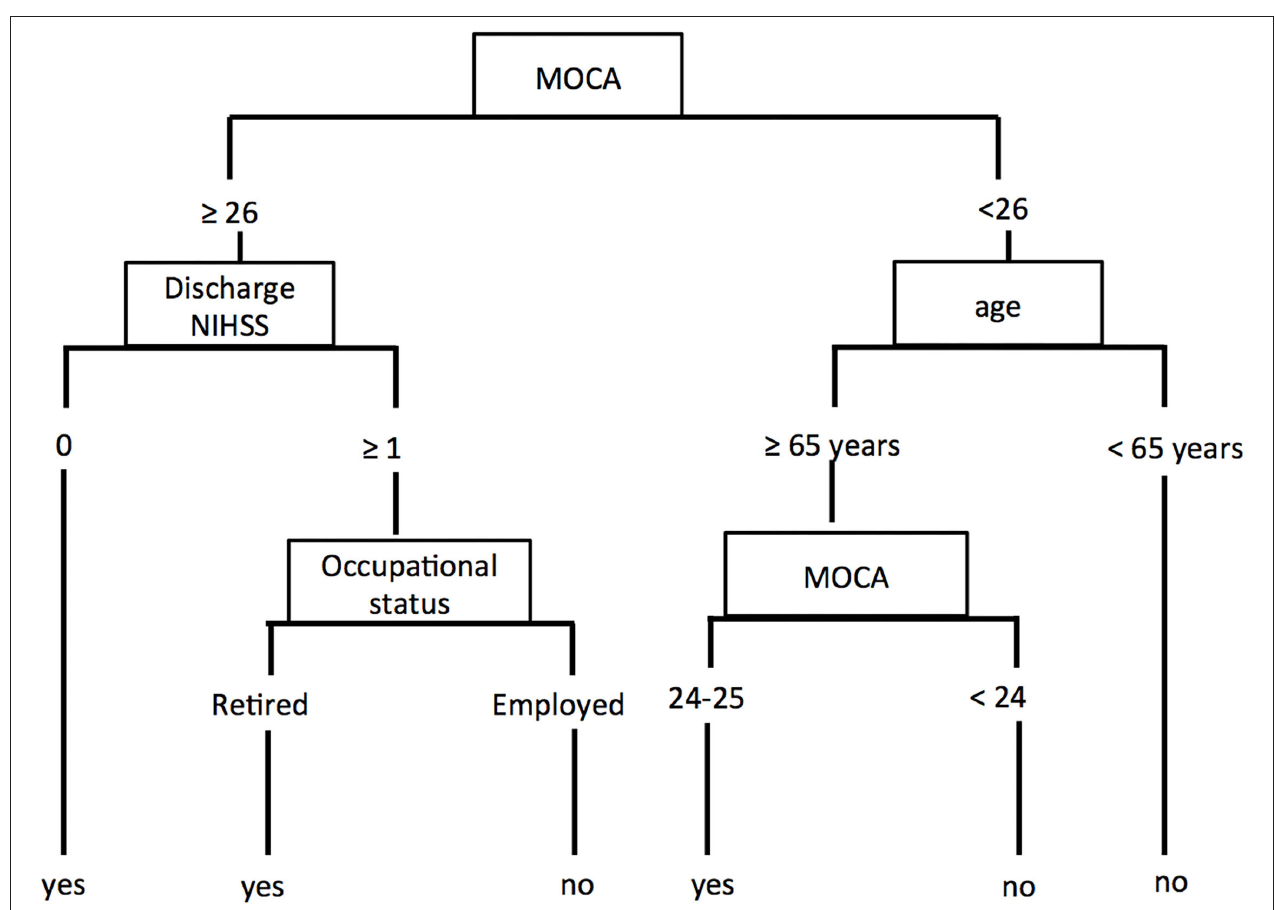
FIGURE 2 | Decision tree to predict favorable